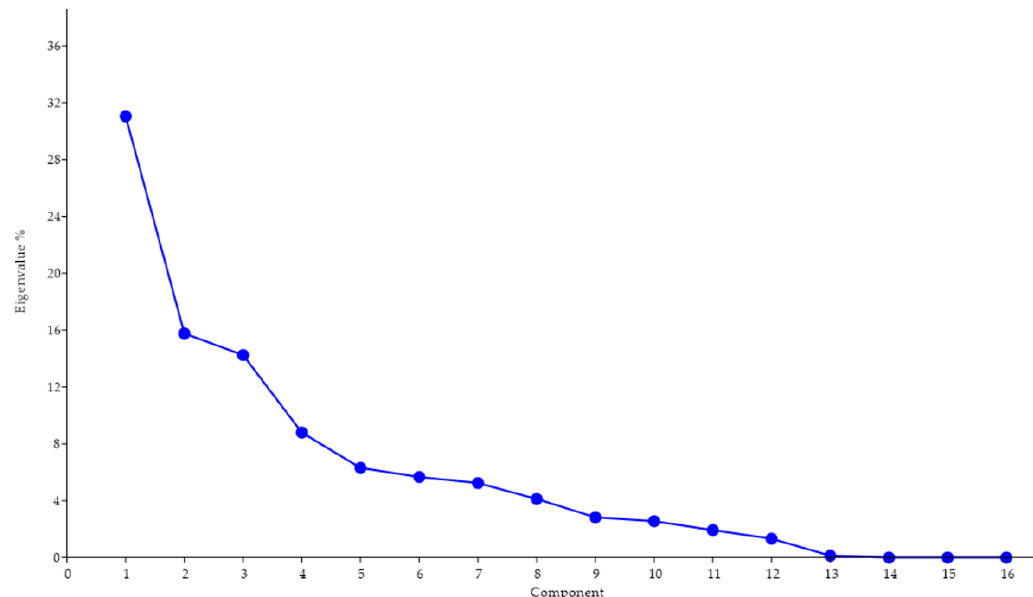
Figure 2. Principal Component Analysis for left and right acropodium asymmetries belonging to 17 Pyrenean Brown calves. The first two Principal Components were statistically meaningful and portrayed 46.80% of the total shape asymmetry, with PC1 accounting for 31.04% of the variance.